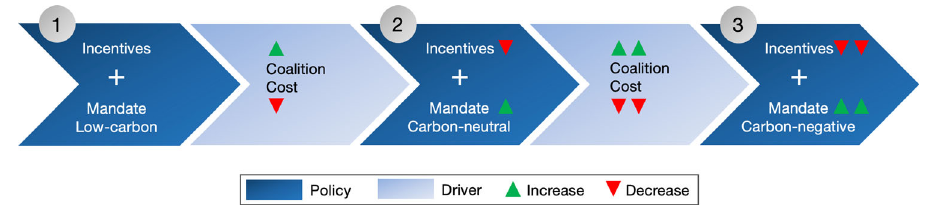
Fig. 2 Policy sequence for climate leaders to develop DAC technology. Climate leaders, in particular those with an existing LCFS, could start market development for DAC through an “ incentive + mandate ” policy mix. Over time, they could ratchet up the stringency of mandates, while